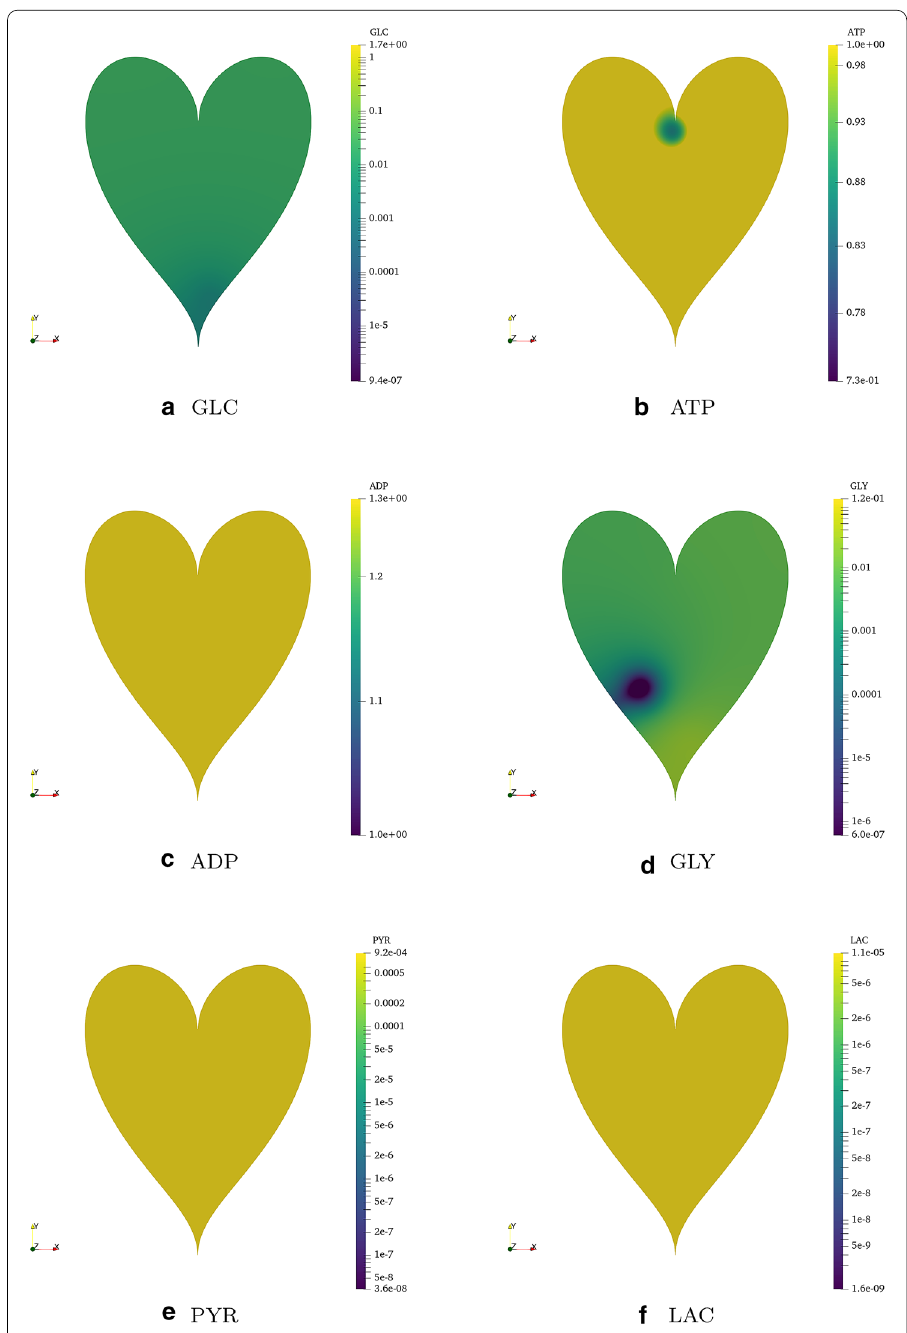
Fig. 11 Solution of the Model obtained in a heart-shaped domain at the final time (T=10). From top to bottom from left to right: [GLC] , [ATP] , [ADP] , [GLY] , [PYR] , [LAC]. GLC is still consumed in the infimum where HXK is. ADP, PYR and LAC have reached a state where the amount of concentration is uniformly distributed into the domain. ATP is consumed to produce ADP by act and produced by the Mito reaction. GLY is consumed by PYRK and produced by